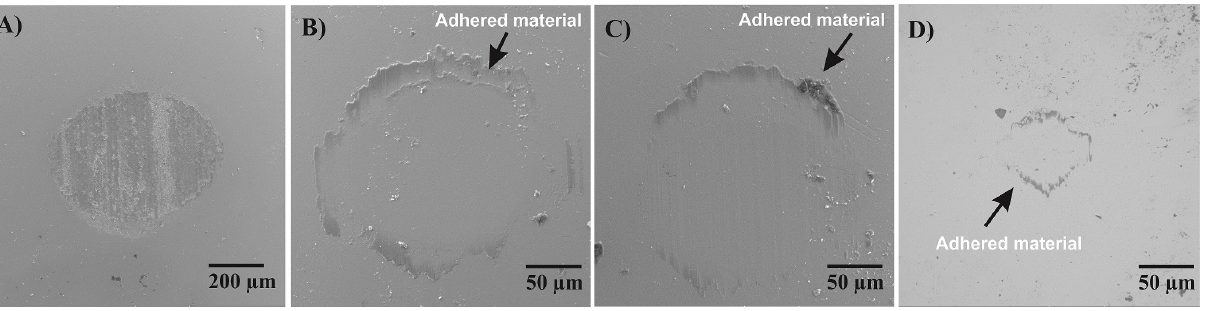
ples, TiAM-PEO 200v (1.99 × 10 − 6 mm³/s) and TiAM-PEO 250v (2.19 × 10 − 6 mm 3 /s). These results indicate that the density of the coatings, pore size (Table 1), and morphology (Figure 1) play a key role in the wear resistance. The two denser coatings (TiAM-PEO 200v and TiAM- PEO 250v ) had lower wear rates concerning the TiAM-PEO 300v , which in turn shows a hol- low-sponge mixed structure with larger pores due to the higher applied voltage that in- duces the formation of more intense discharges during the formation of PEO coatings. Regarding this, the TiAM-PEO 200v and TiAM-PEO 250v have a uniform energy distribution in the first phases of the formation of the coating, resulting in lower energy discharges and allowing fewer defects.